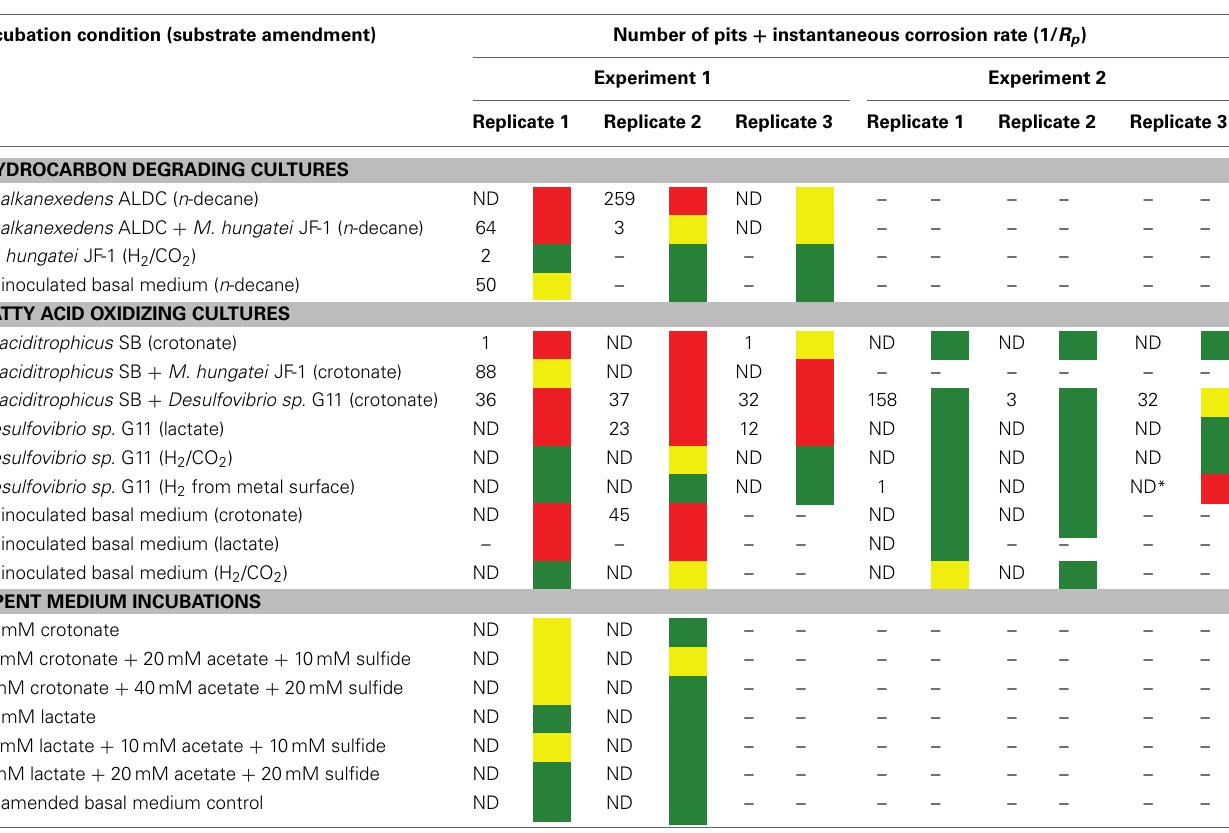
Table 4 | The number of pits and the instantaneous corrosion rates for replicates of the hydrocarbon and fatty acid oxidizing cultures as well as the spent medium